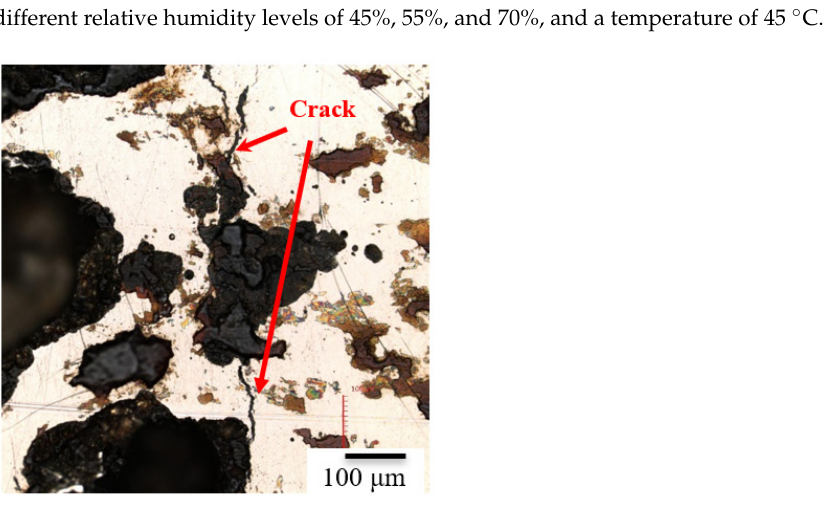
Figure 5. The round specimens show cracks after crevice corrosion testing at the relative humidity of 70% for 5000 h with 1 g/m 2 of sea salt deposited on the surface. 70% for 5000 h with 1 g/m 2 of sea salt deposited on the